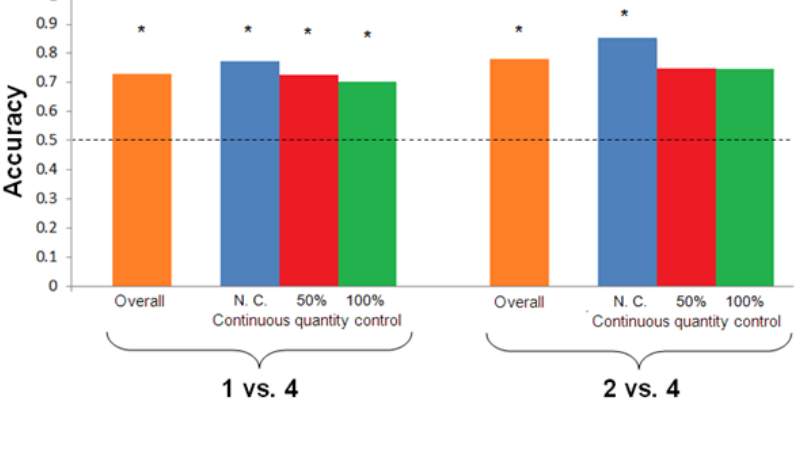
Figure 2. Accuracy (proportion of correct choices) is plotted against the type of stimuli (non-controlled, 50% controlled, 100% controlled stimuli) separately for each Test. Asterisks (*) denote a significant departure from chance level. Horizontal dashed line indicates chance